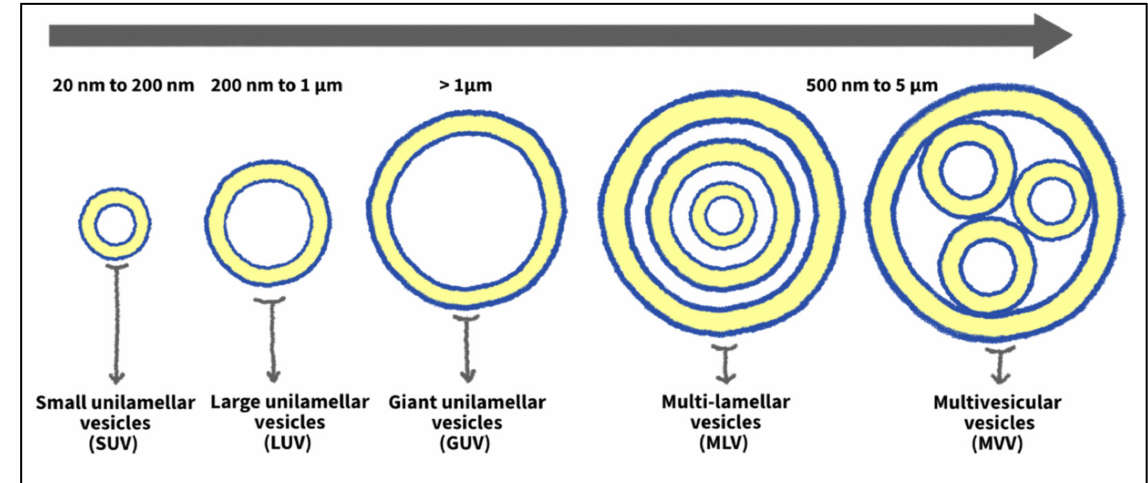
Figure 3. Classification of liposomes based on size and